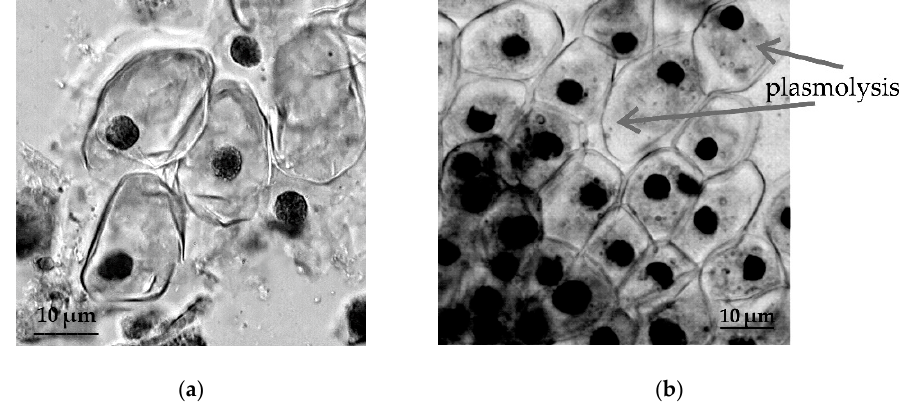
Figure 5. The effect of induced water deficit on RAM cells T. aestivum : ( a ), control, ( b ), stress (sucrose,